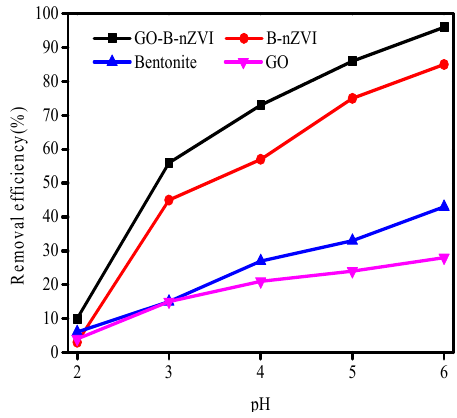
Figure 8. Removal efficiency of Cu(II) by bentonite, GO, B-nZVI, and GO-B-nZVI with pH (Temperature = 18 °C; adsorbent dose = 1 g·L − 1 ; concentration of Cu(II) = 80 mg·L − 1 ; adsorption time = 24 h).